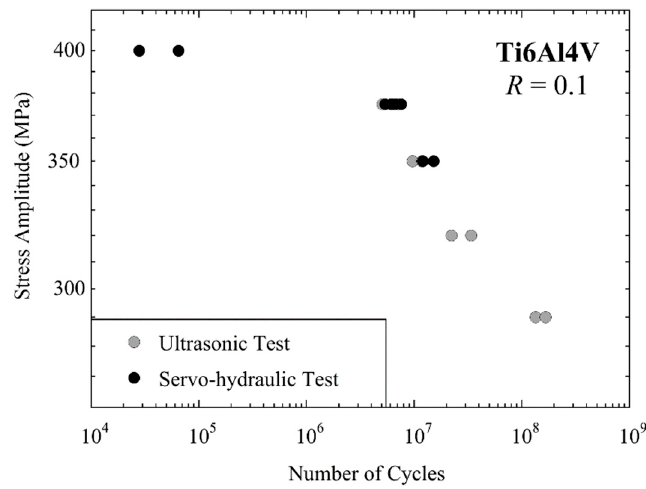
Figure 12. Fatigue data of Ti6Al4V ELI (mill annealed) measured at R = 0.1 with servo ‐ hydraulic equipment at 55 Hz cycling frequency (black) and with ultrasonic equipment at 20 kHz (grey).